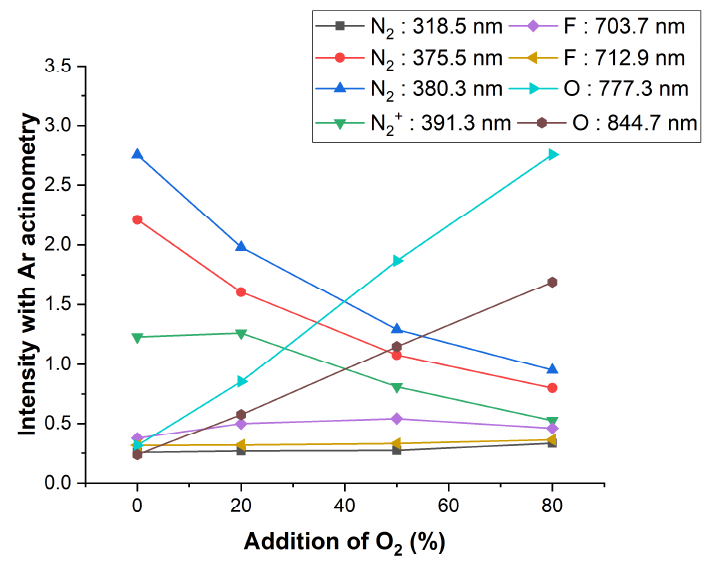
Figure 8. NF 3 + O 2 plasma peak intensity change with the addition of oxygen gas.